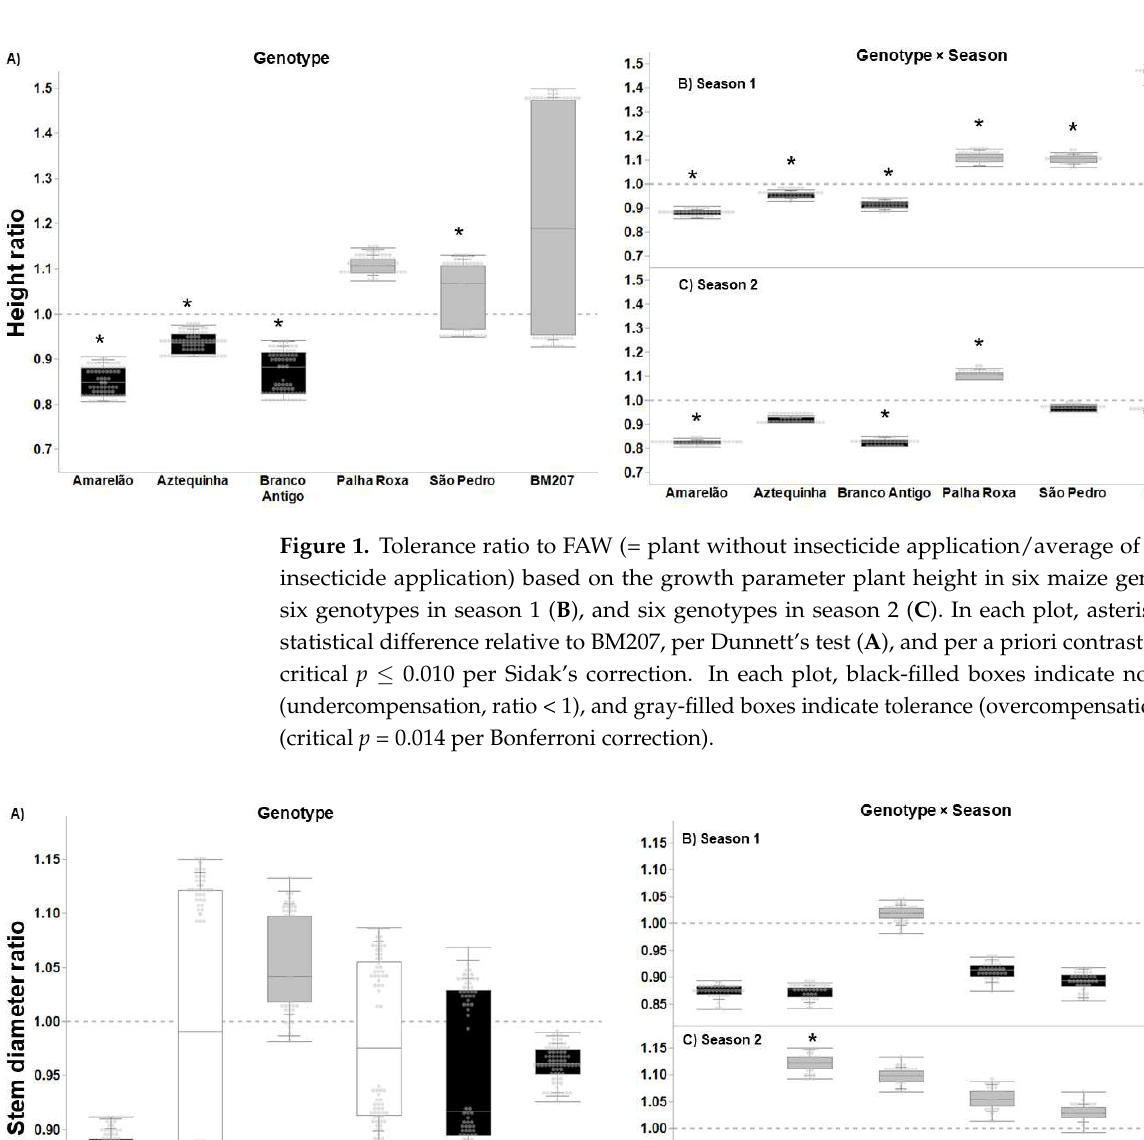
Figure 2. Tolerance ratio to FAW (= plant without insecticide application/average of plants with insecticide application) based on the growth parameter stem diameter in six maize genotypes ( A ), six genotypes in season 1 ( B ), and six genotypes in season 2 ( C ). In each plot, asterisks indicate statistical difference relative to BM207, per Dunnett’s test ( A ), and per a priori contrasts ( B , C ) with critical p ≤ 0.010 per Sidak’s correction. In each plot, black-filled boxes indicate non-tolerance (under- compensation, ratio < 1), gray-filled (overcompensation, ratio > 1) and white-filled (compensation, ratio = 1) boxes indicate tolerance (critical p = 0.014 per Bonferroni